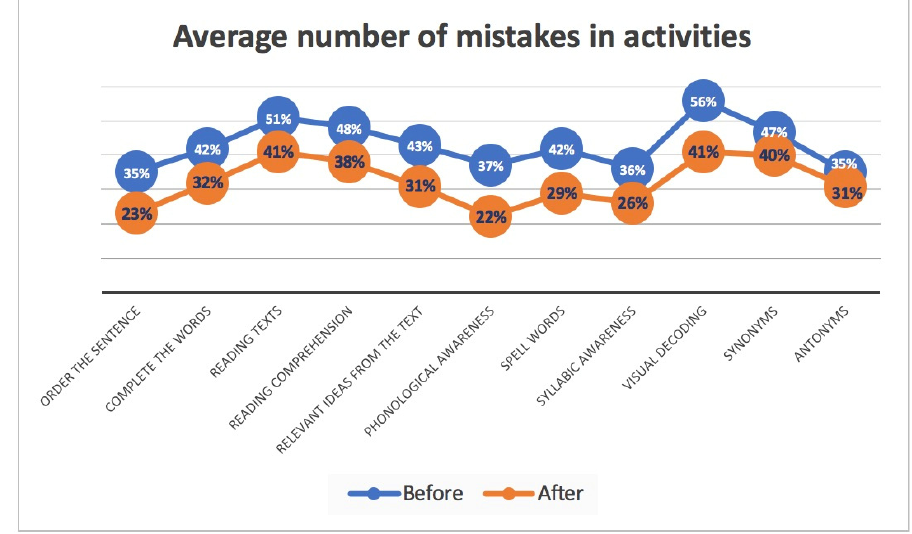
Figure 10. Decrease in mistakes in activities carried out by